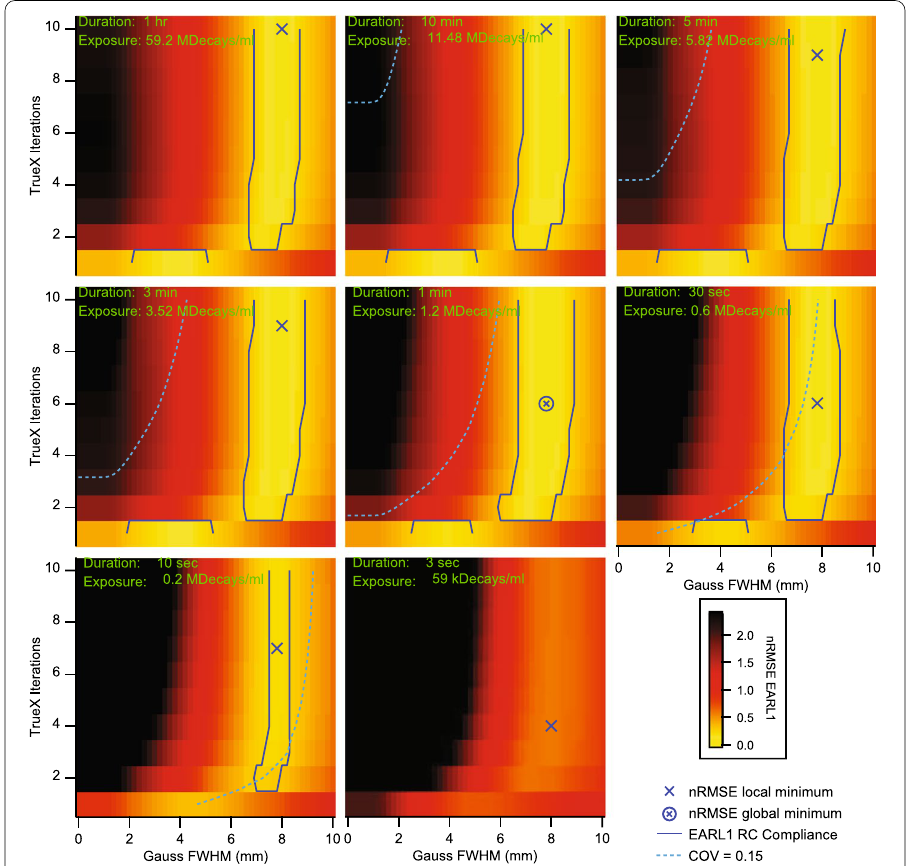
Fig. 2 Normalized RMSE for RC max and RC mean in reconstruction parameter space. Data sets within the blue contour passed the current EARL1 recovery curve limits; each panel represents a different exposure. The light blue dotted lines mark the EARL COV cut‑off values from Fig. 1; compliant data sets were found on the dotted line’s right side. The blue cross marks the local nRMSE minima; the cross in the circle marks the global nRMSE minimum. Panels are shown in order of decreasing